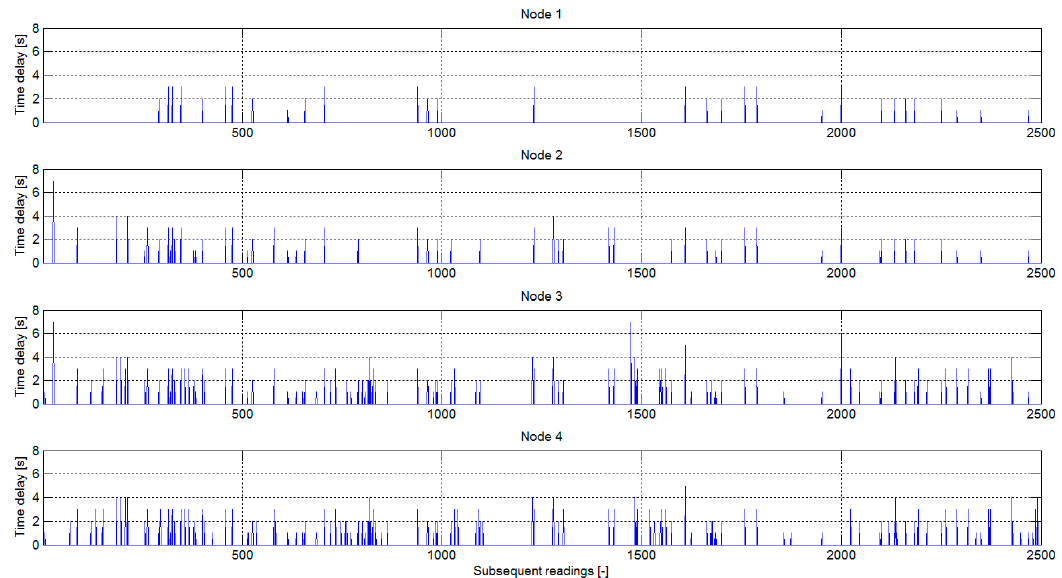
Figure 17. Recorded time delays during subsequent data transmissions.